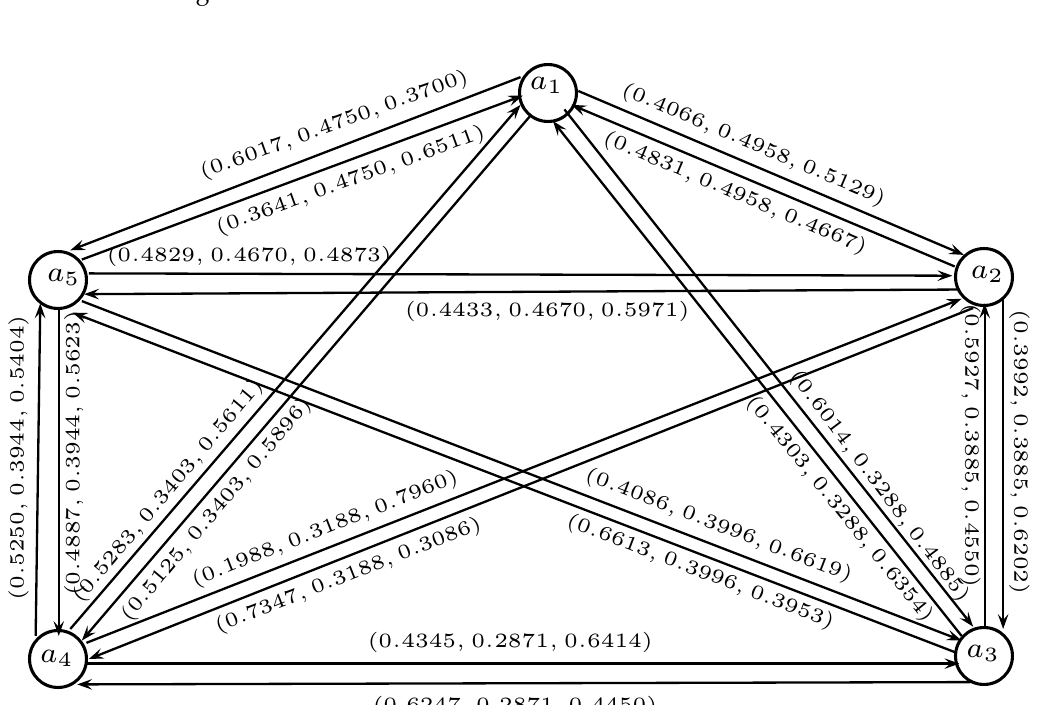
Figure 21. Directed model of the combined Figure 21: Directed model of the combined SFPR